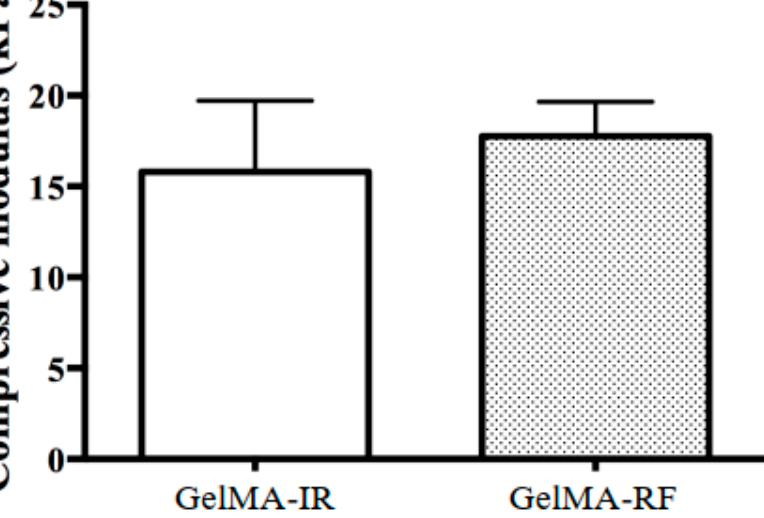
Figure 2. Mechanical properties of a GelMA–RF hydrogel and a GelMA–Irgacure2959 (IR) hydrogel. The compressive moduli of a GelMA-RF hydrogel and a GelMA-IR hydrogel were measured and appeared to not be significantly different. The stiffness of the two hydrogels was within the range suitable for osteoblast differentiation. Error bars represent the SD of measurements performed on five samples.